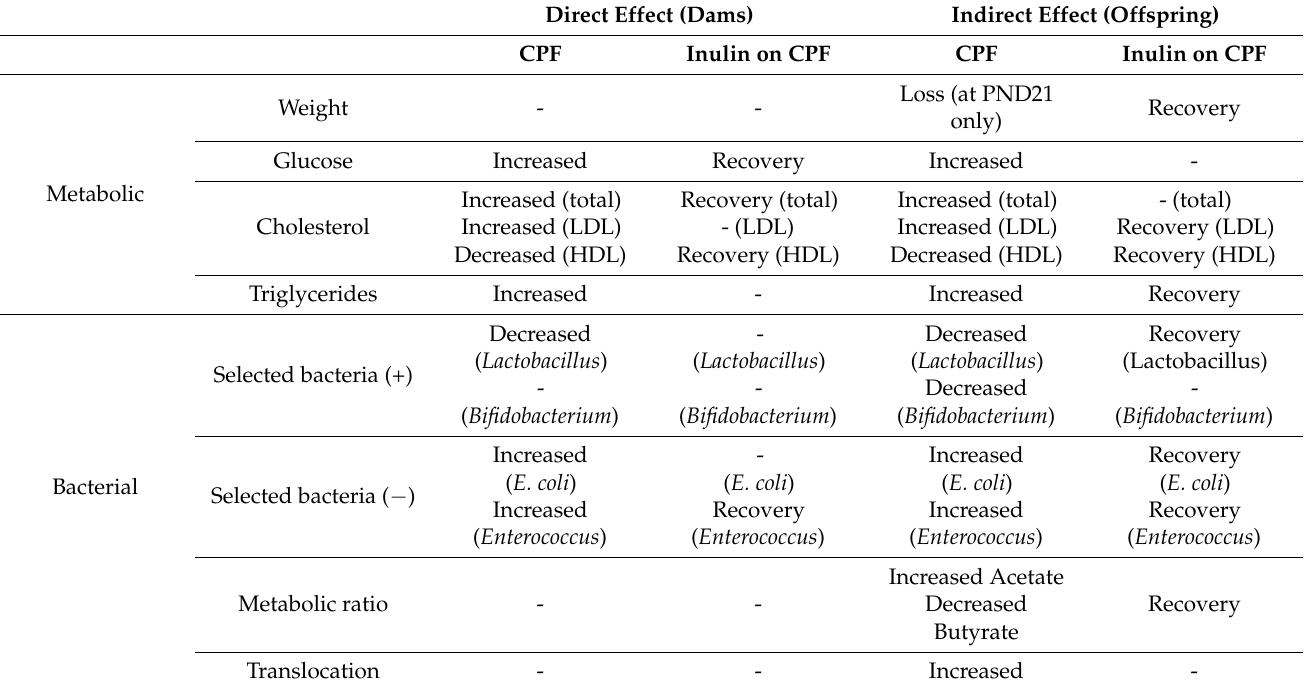
Table 5. Summary of direct and indirect impact of CPF and protective impact of inulin